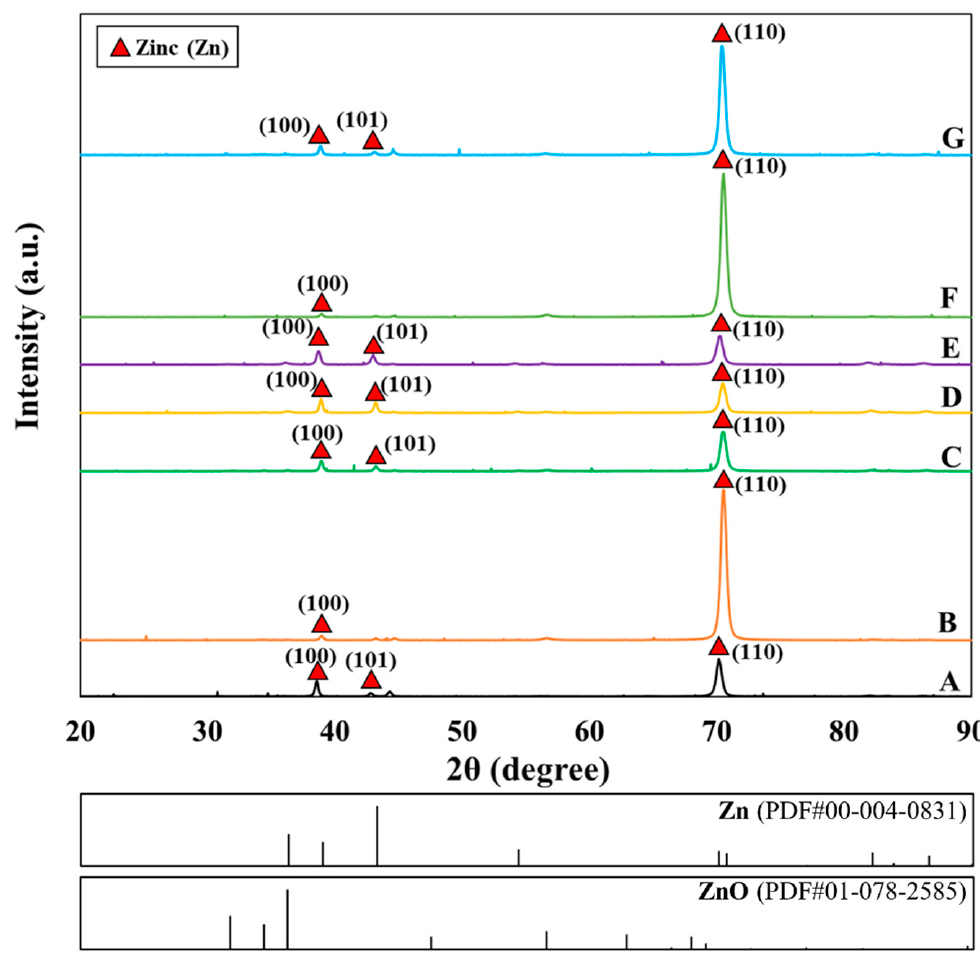
Figure 3. XRD profiles of specimens from different plating baths formulations.